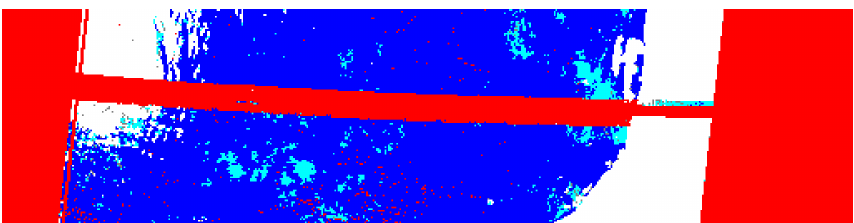
Figure 5. Map of the MISR RCCM for Path 168, Orbit 98340, Block 113 and camera BA. Note the variable thickness of the missing data band when crossing the shoreline between the continent and the Indian Ocean (see text for details). The linear dimensions of the mapped area and the color coding are identical to those indicated in Fig.